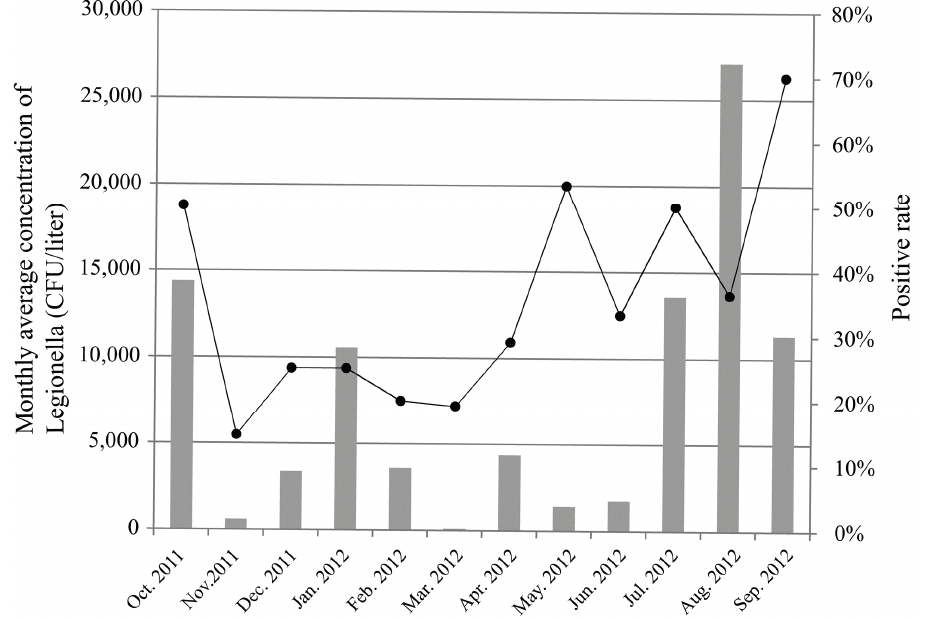
Figure 1. The positive rate and monthly average concentration of Legionella of factory A between October 2011 and September 2012. The curve represents the positive rate, and the histogram represents the monthly average